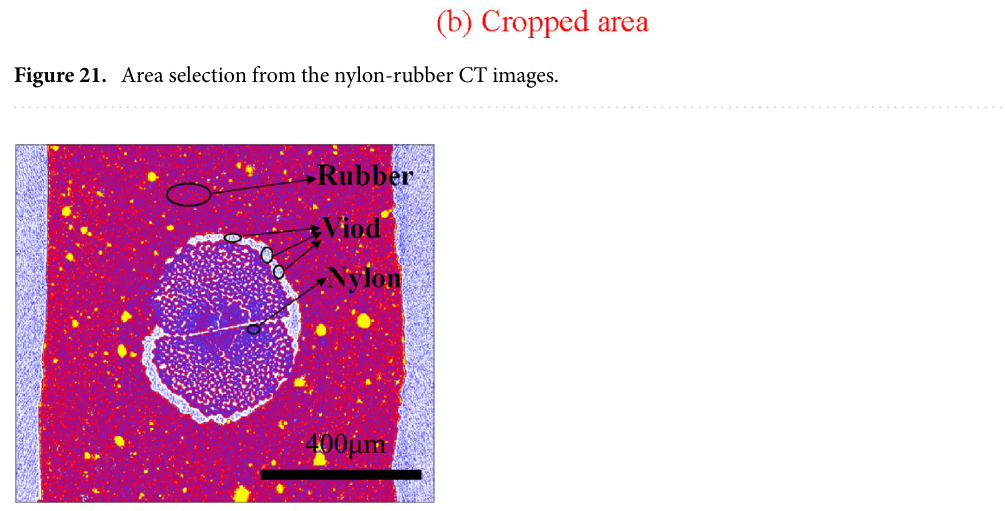
Figure 22. The division diagram of nylon-rubber-void (the surrounding red areas are rubber, purple areas are nylon, and white areas are